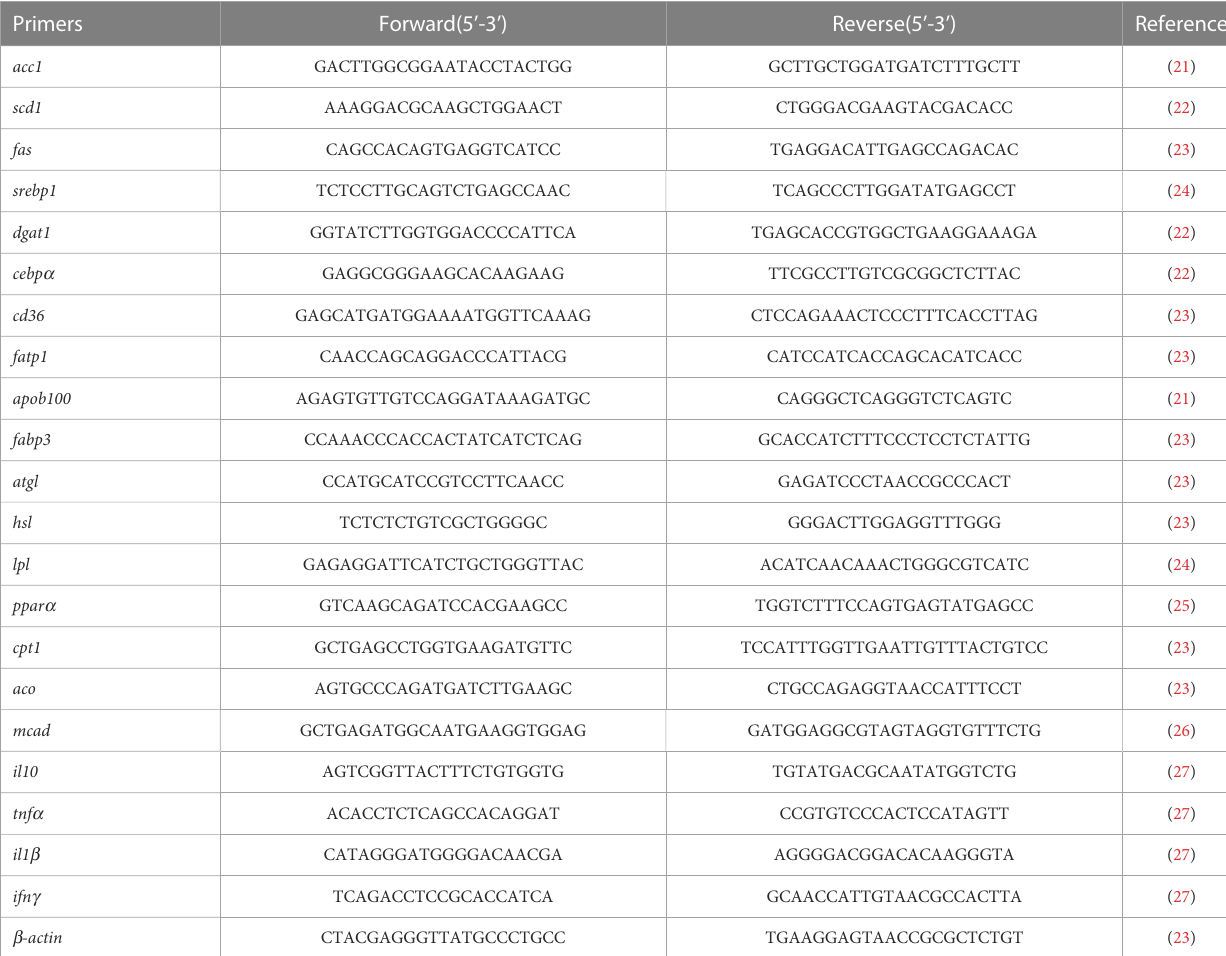
TABLE 1 Primers used for real-time quantitative PCR. Primers Forward(5 ’ -3 ’